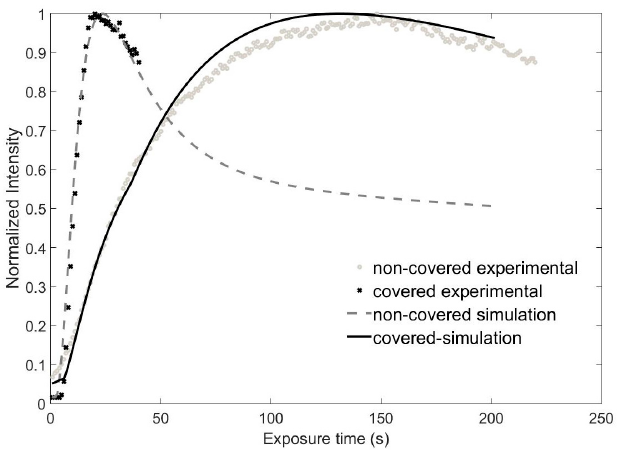
Figure 6. Normalized intensity as a function of recording time at the focal point for the same sample without cover-plate and covered and index matched: experiments and simulations. Focal length of 13 cm.